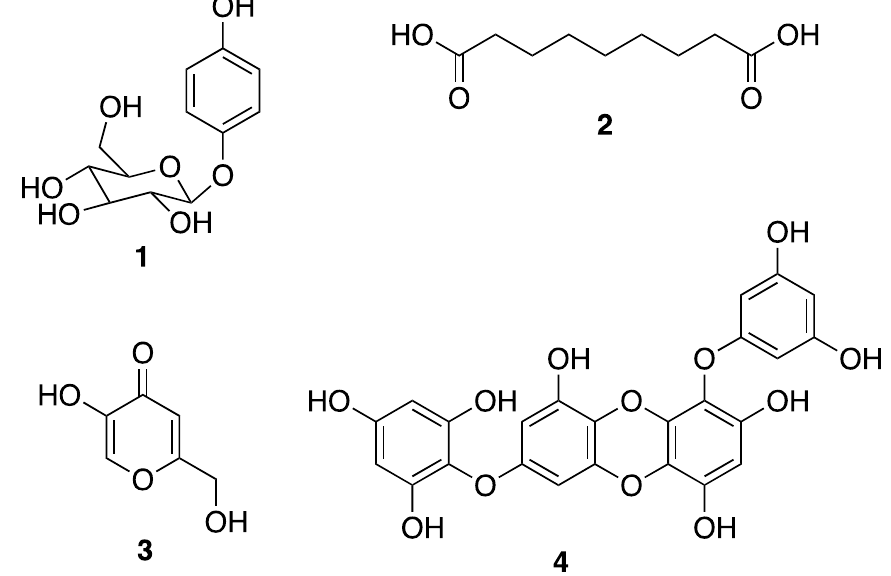
Figure 1. Structures of arbutin ( 1 ), azelaic acid ( 2 ), kojic acid ( 3 ), and 7-phloroeckol ( 4 ).